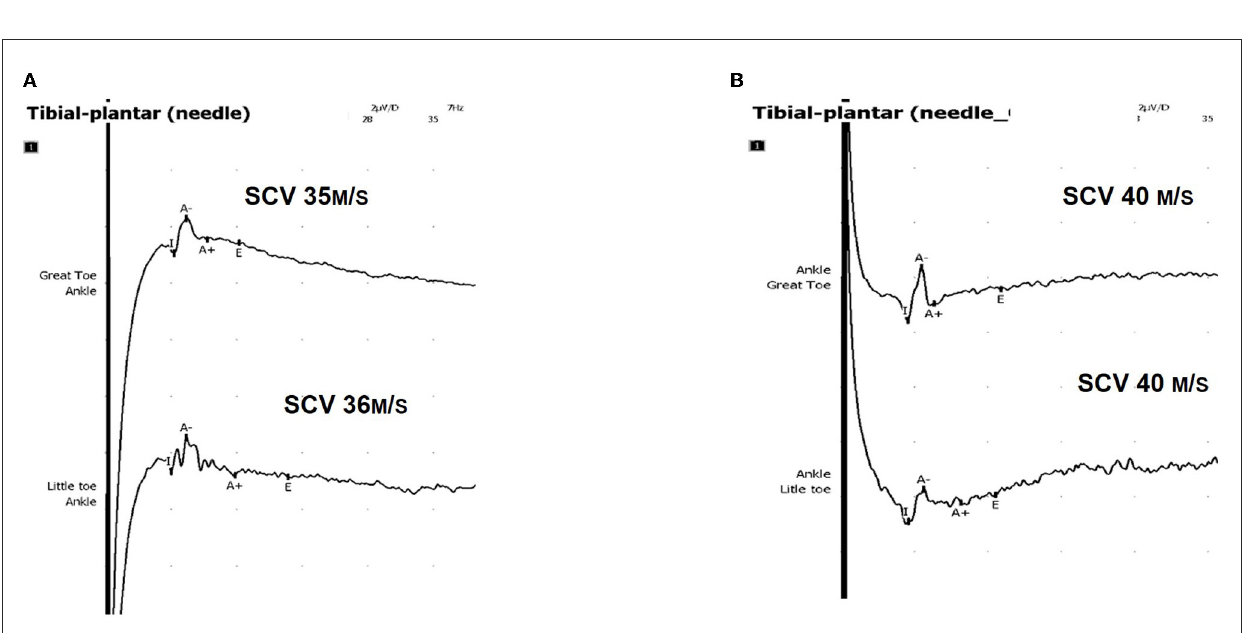
the local vascular supply at the site of nerve entrapment. Based